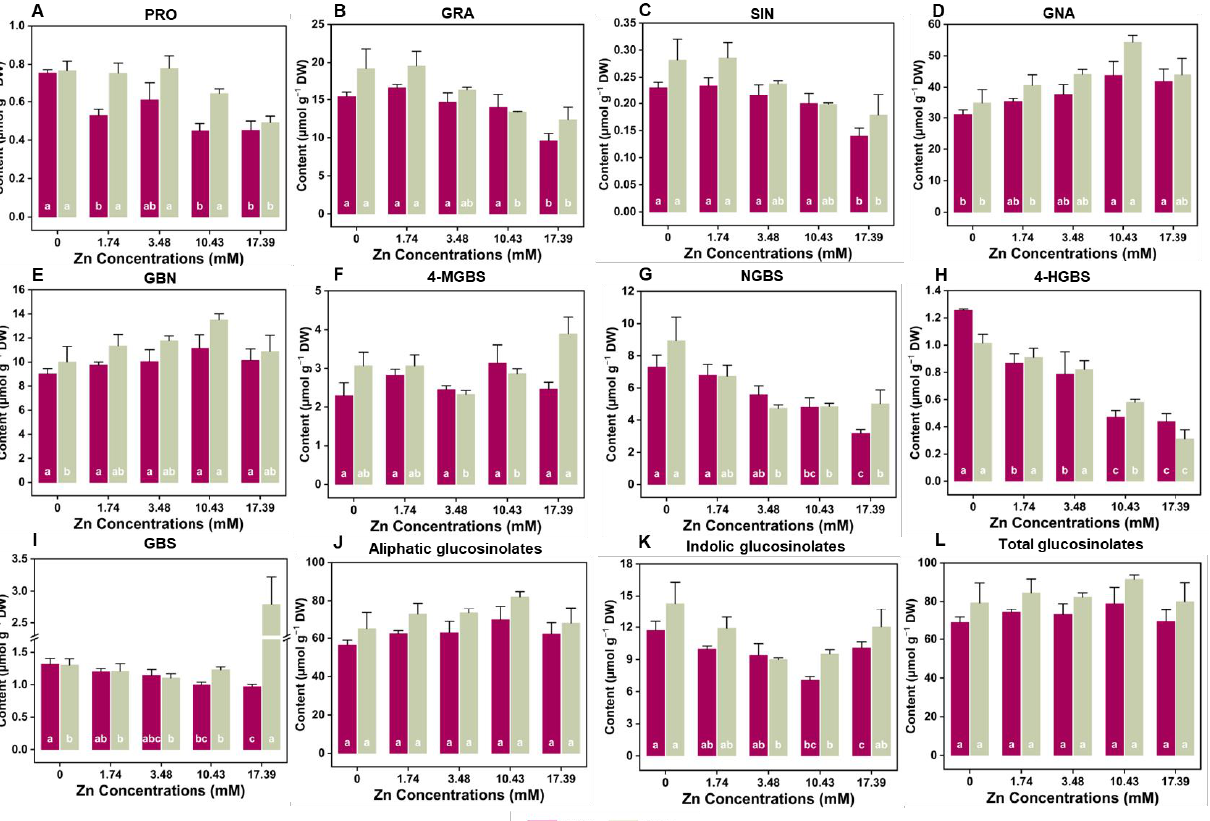
Figure 6. The contents of individual glucosinolate ( A : PRO, B : GRA, C : SIN, D : GNA, E : GBN, F : 4 − MGBS, G : NGBS, H : 4 − HGBS, I : GBS), aliphatic glucosinolates (AGLs) ( J ), indolic glucosinolates (IGLs) ( K ) and total glucosinolates content (TGLs) ( L ) in flowering Chinese cabbage sprouts (FCCS) grown under combination of Zn concentration and R-B ratio (ratios of red and blue light). The letters marked in all figures indicate the significant difference under Zn treatments ( p ≤ 0.05, Duncan’s test). Table 6. The interaction effects of individual glucosinolate contents and total glucosinolate content in flowering Chinese cabbage sprouts (FCCS).